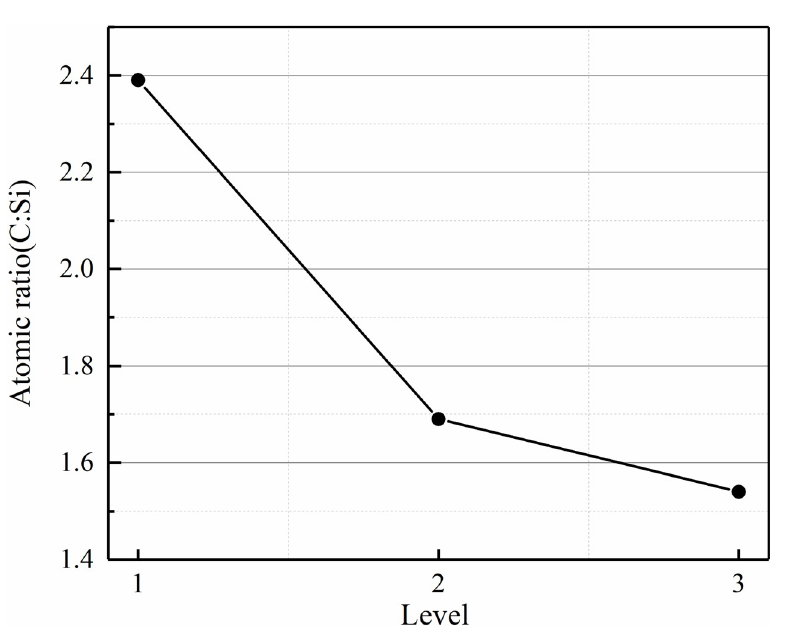
Fig 10. Atomic ratio (C:Si) of the RTV samples at different ageing levels.